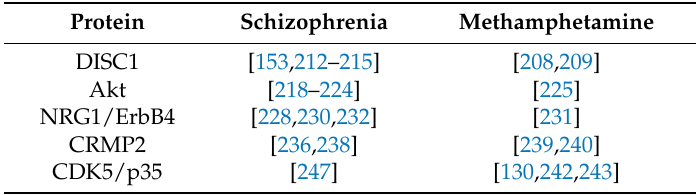
Table 1. Altered proteins converging on the mammalian target of rapamycin (mTOR) pathway during schizophrenia and methamphetamine addiction. DISC1—disrupted in schizophrenia